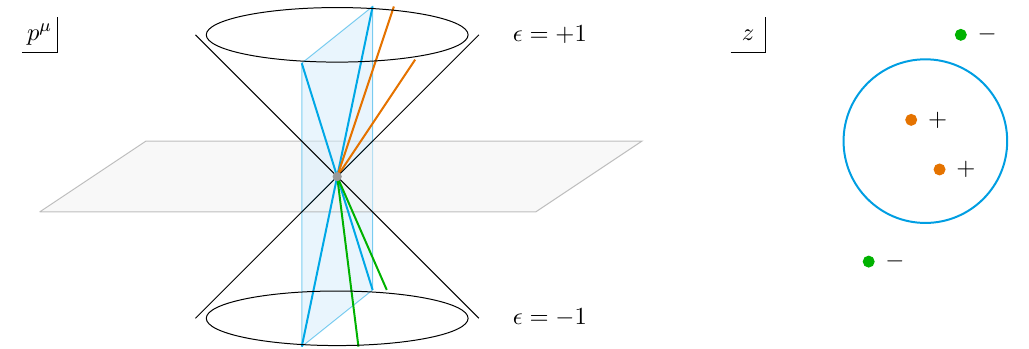
Figure 2 . Left: hyperplanes through the origin of momentum space with spacelike normal (blue) divide the set of on-shell momentum-directions in two (orange and green). A dual vector v µ will satisfy vQ > 0 if all of the rays are on the same side of this hyperplane. Right: the antipodal identification of the incoming and outgoing celestial spheres implies the corresponding circle divides the incoming (orange) from the outgoing (green)